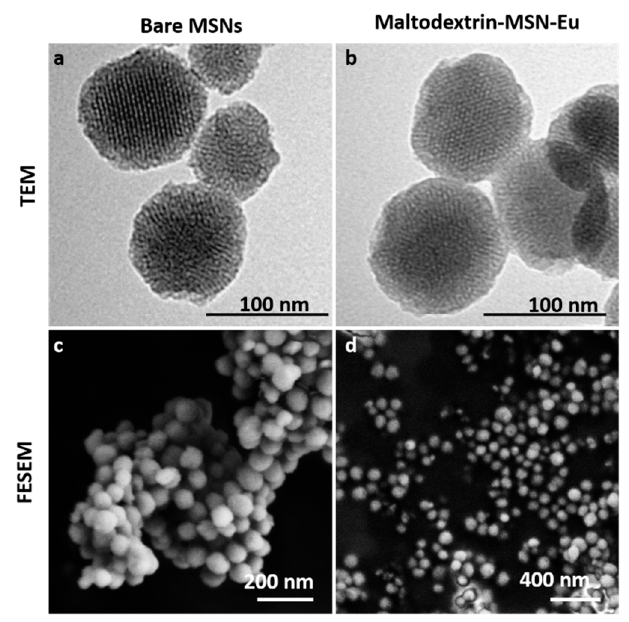
Figure 4. TEM images of bare MSN ( a ) and Maltodextrin-MSN-Eu ( b ), and FESEM images of bare MSN ( c ) and Maltodextrin-MSN-Eu ( d ), showing the typical shape and structured pores of the MCM-41 matrix.